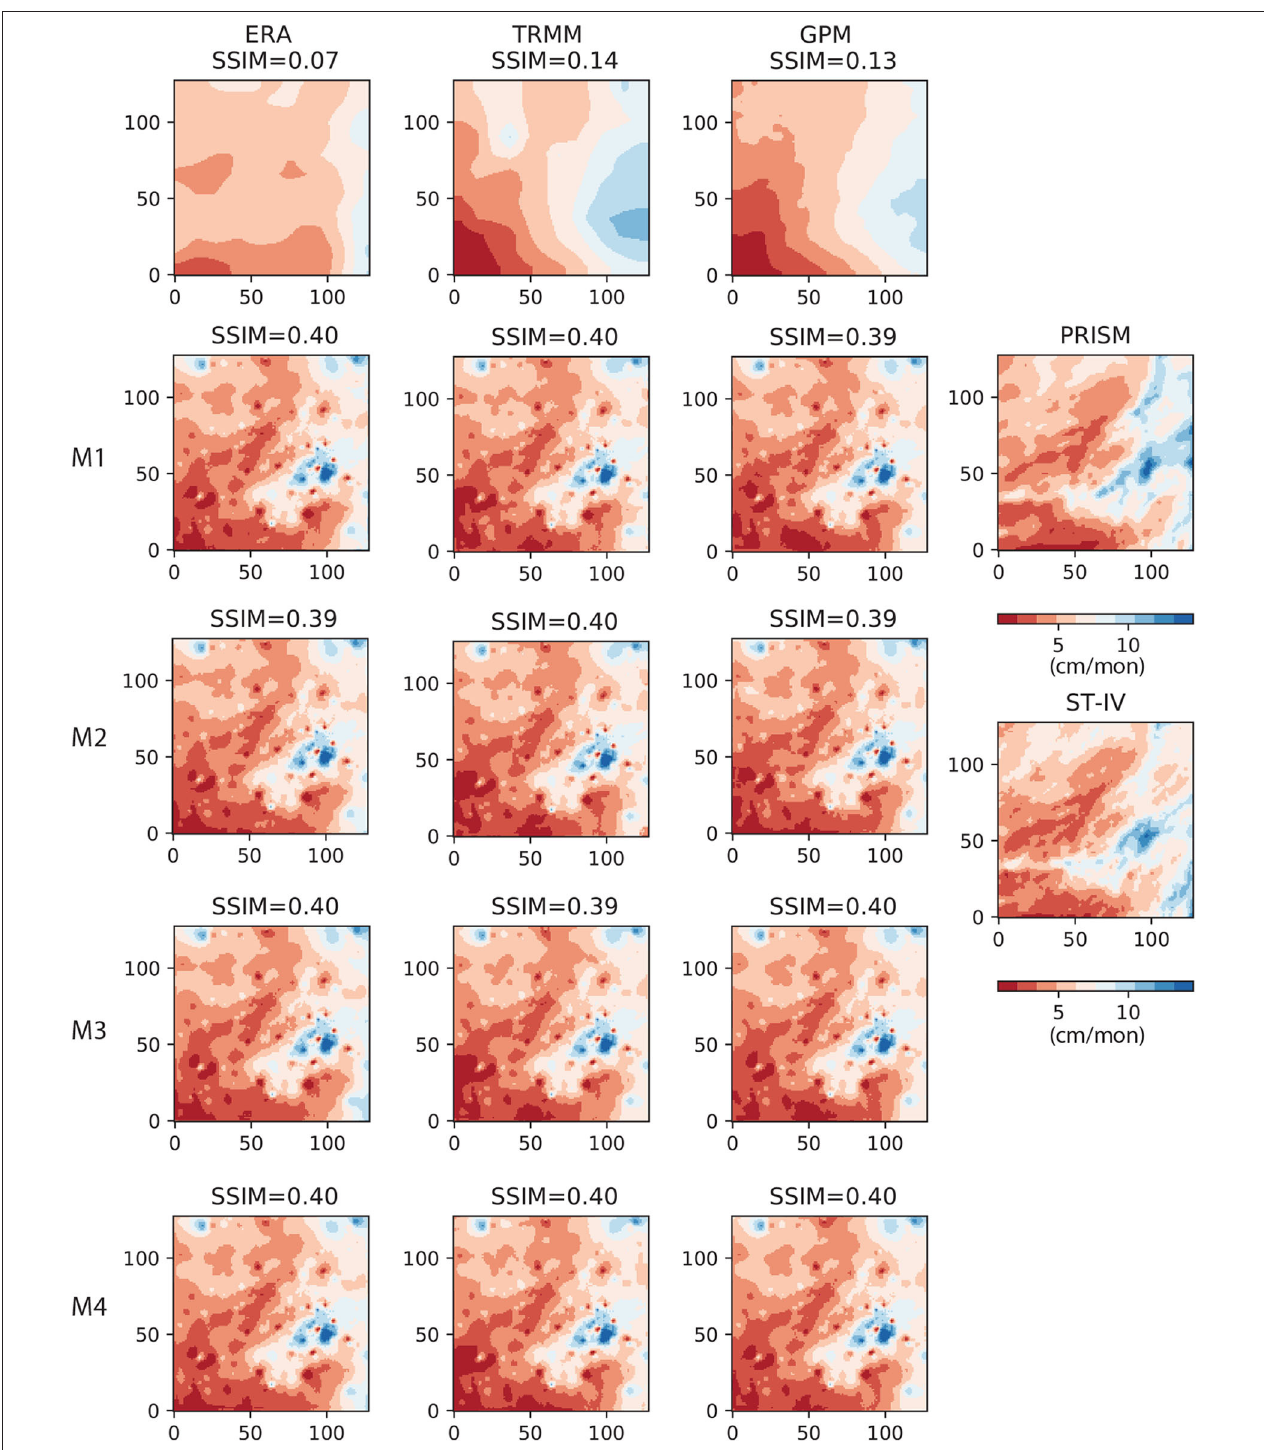
FIGURE 11 | Results of gauge correction using inverse distance weighting on 2017/01 data. Left column (from top to bottom) ERA5 and the corresponding M 1 − M 4 AU-Net models; 2nd column: TRMM and the corresponding AU-Net models; 3rd column: GPM and the corresponding AU-Net models; rightmost column: reference PRISM and Stage-IV data for the same